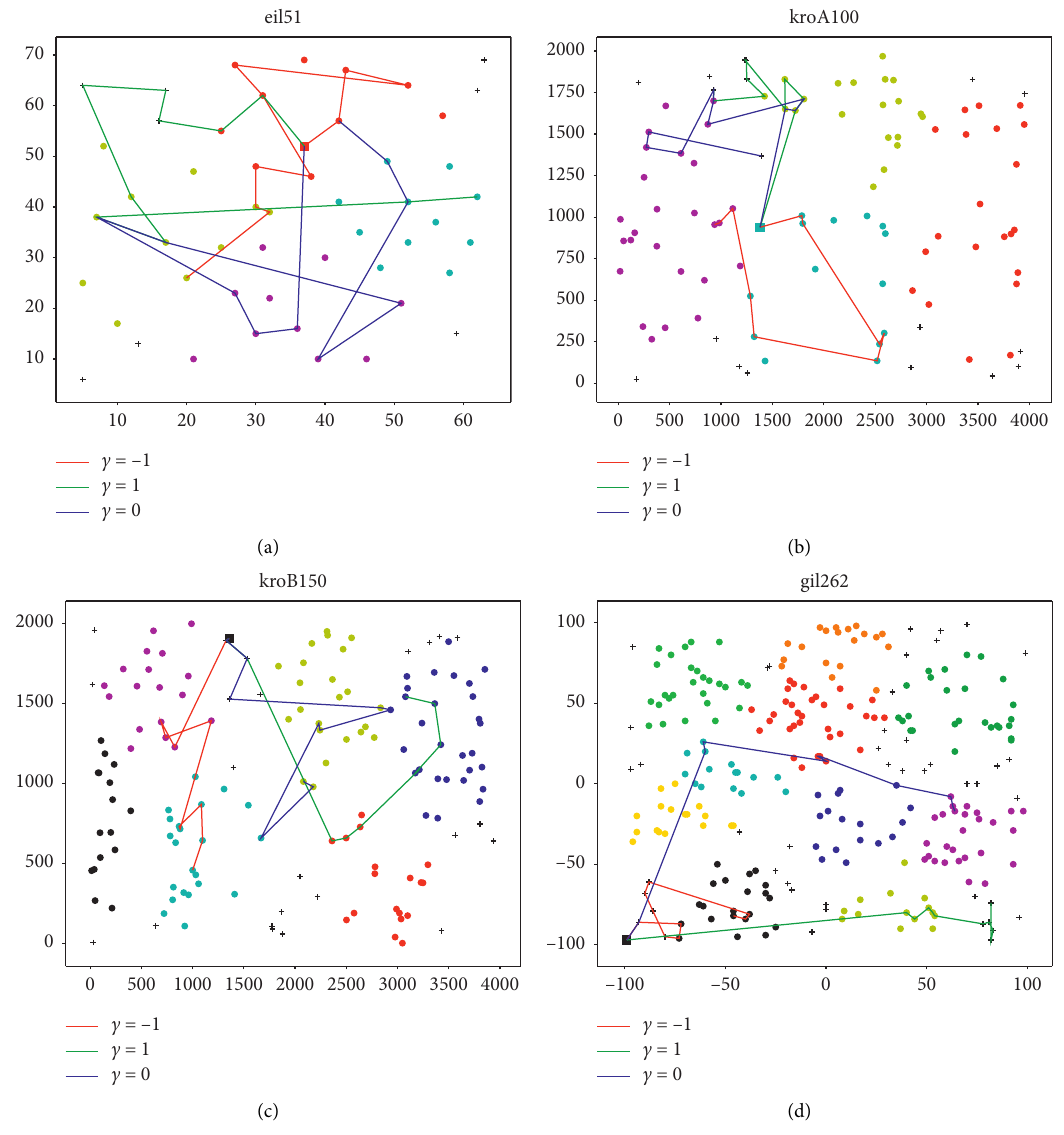
Figure 3: The effect of search strategy on (a) eil51, (b) kroA100, (c) kroB150, and (d)